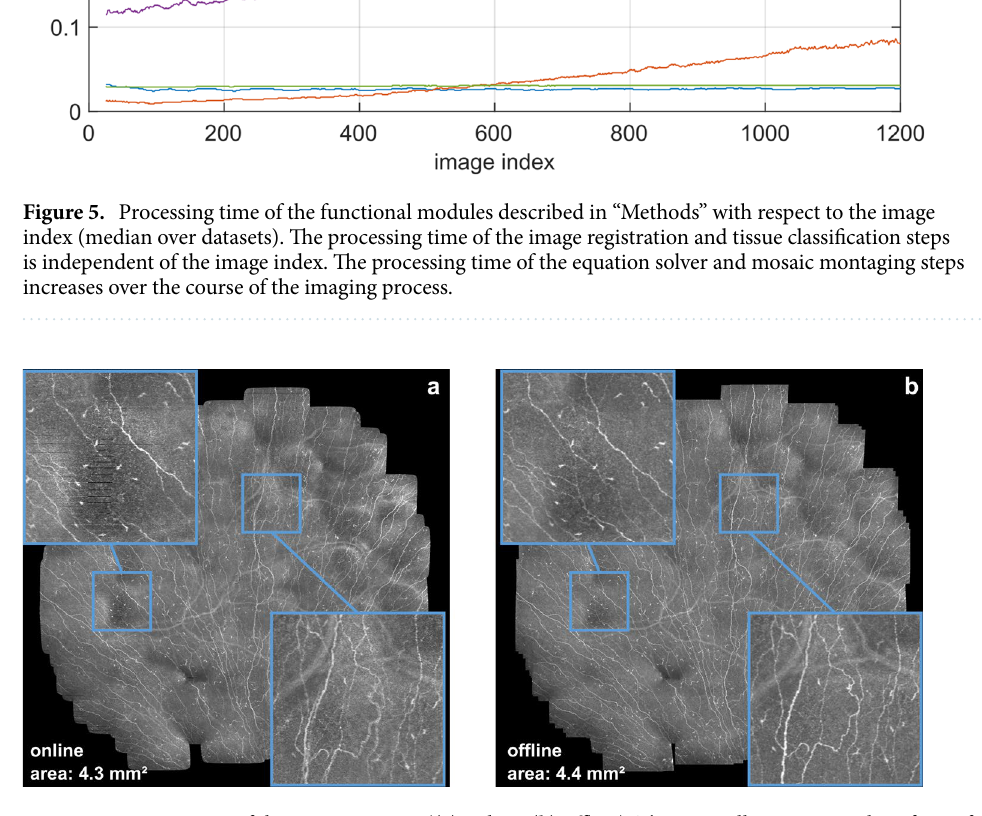
Figure 6. Comparison of the mosaic images ( (a) online, (b) offline). The insets illustrate typical artifacts of the online mosaicking process and the improved image quality available through the additional offline process (The presented example is the third-largest mosaic image of the 111 collected